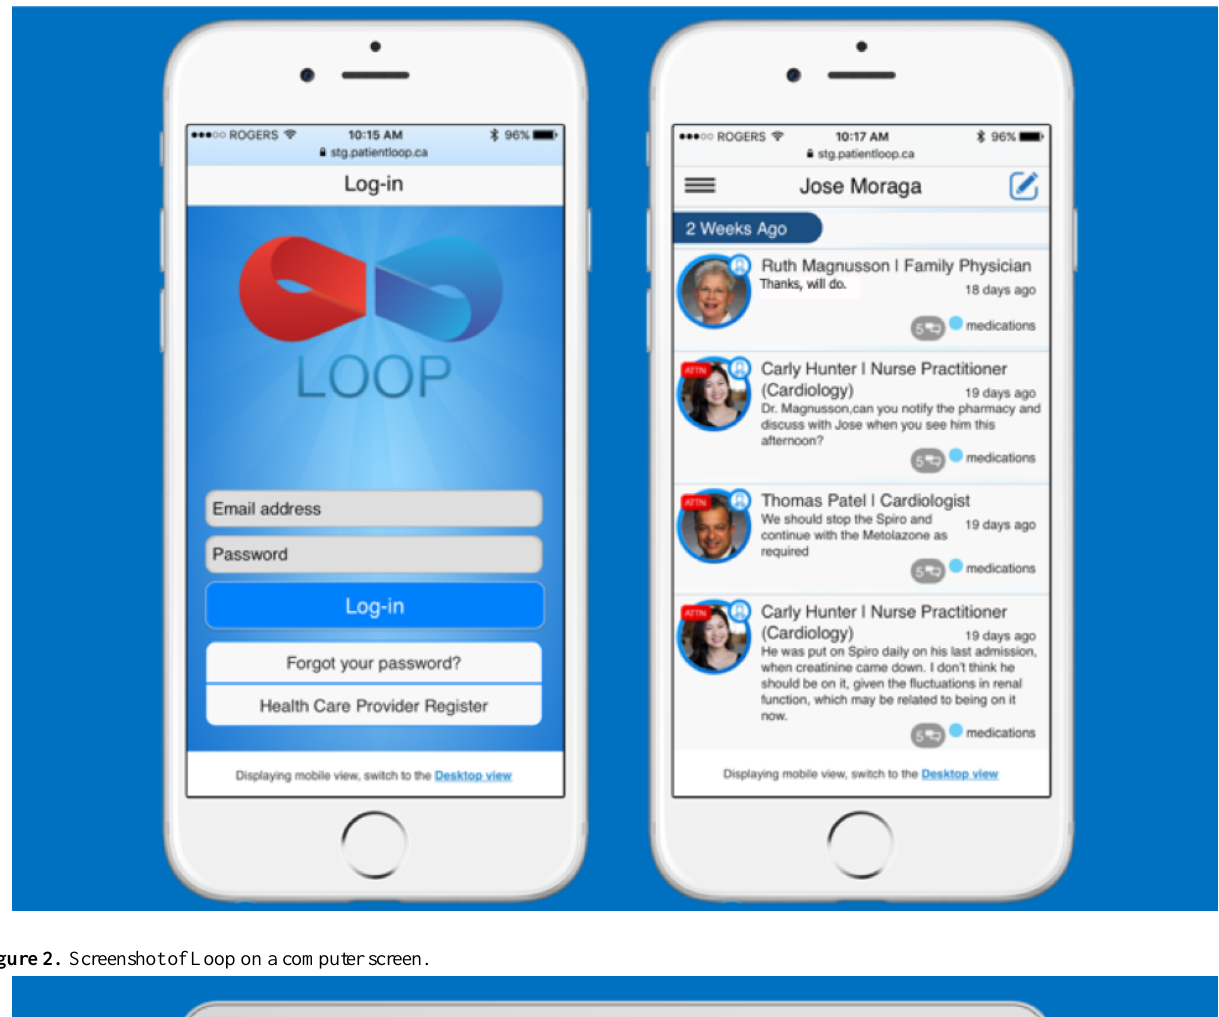
Figure 1. Screenshots of Loop optimized for a smartphone.